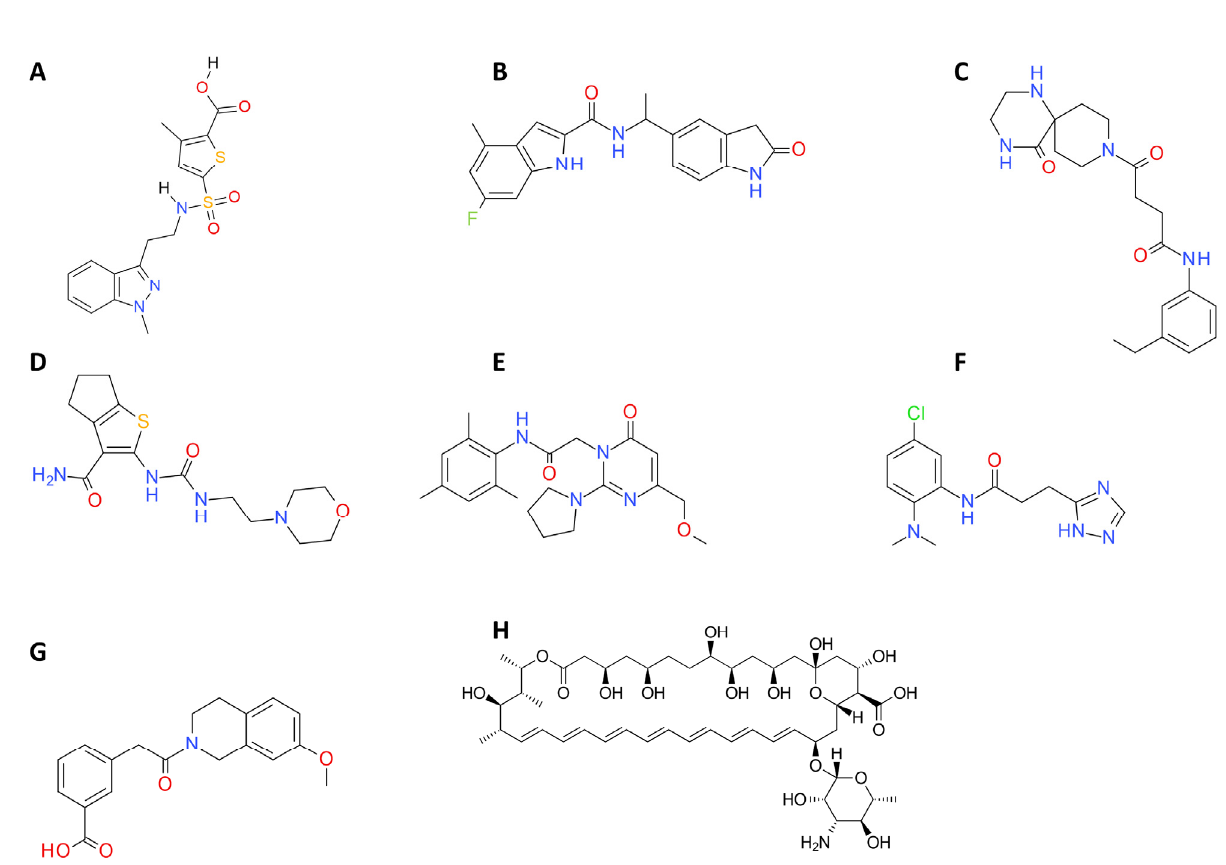
Figure 7. Structures for the in silico identified compounds selected for further in vitro testing. ( A ) CPE1, ( B ) CPE2, ( C ) CPE3, ( D ) CPE4, ( E ) CPE5, ( F ) CPE6, ( G ) CPE7, ( H ) amphotericin B. Table 2. Pharmacokinetics of selected and reference compounds. GI: Predicted gastrointestinal absorption. BBB: Pre- dicted blood–brain barrier permeation. P-gp: Predicted substrate of P glycoprotein. CYP inhibitor: Likelihood of interac- tions with the five most common isoforms of cytochromes P450.